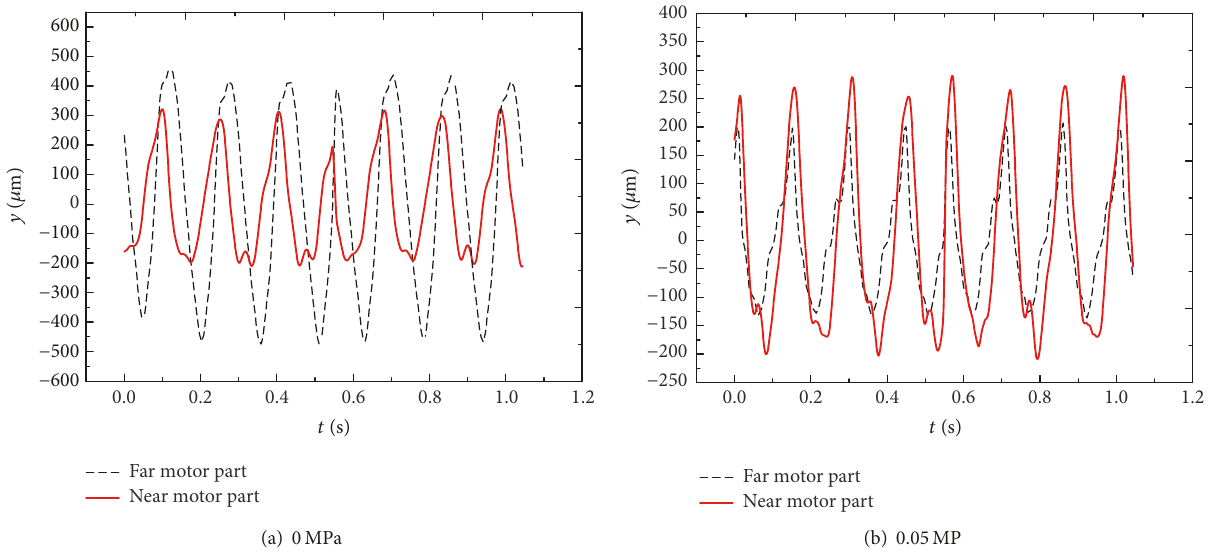
Figure 8: The rotor time domain waveforms in vertical direction, 400r/min.